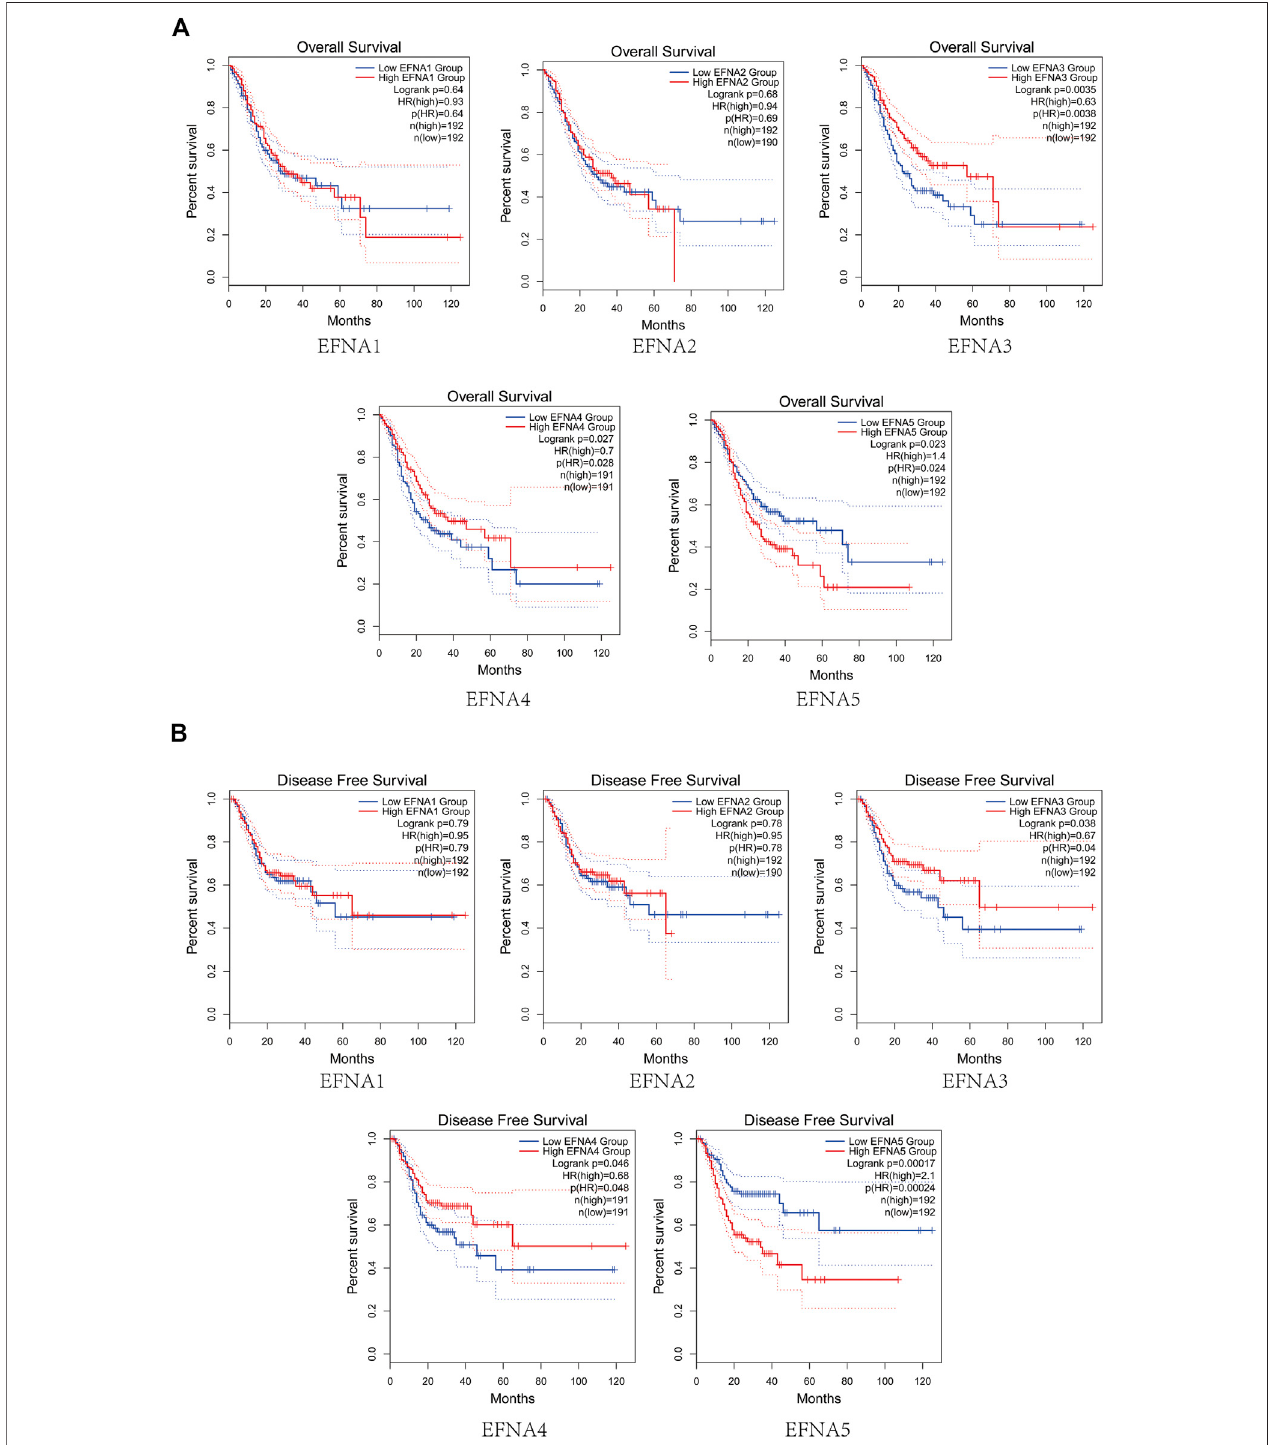
FIGURE 2 | Survival analysis of gastric cancer. (A) Analysis curve of EFNA expression and overall survival rate in gastric cancer (Kaplan-Meier plotter). (B) Analysis curve of EFNA expression and disease-free survival rate in gastric cancer (Kaplan-Meier plotter).